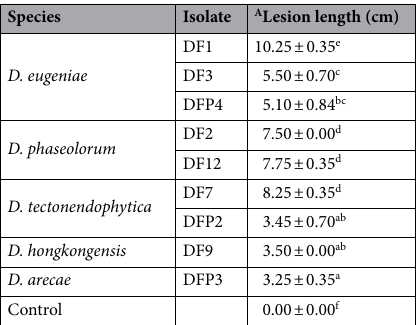
Table 2. Lesion length recorded by Diaporthe isolates after 3 weeks of inoculation on stems of H. polyrhizus. A Mean ± standard deviation followed by different letters within the column is significantly different ( p < 0.05) according to Tukey’s